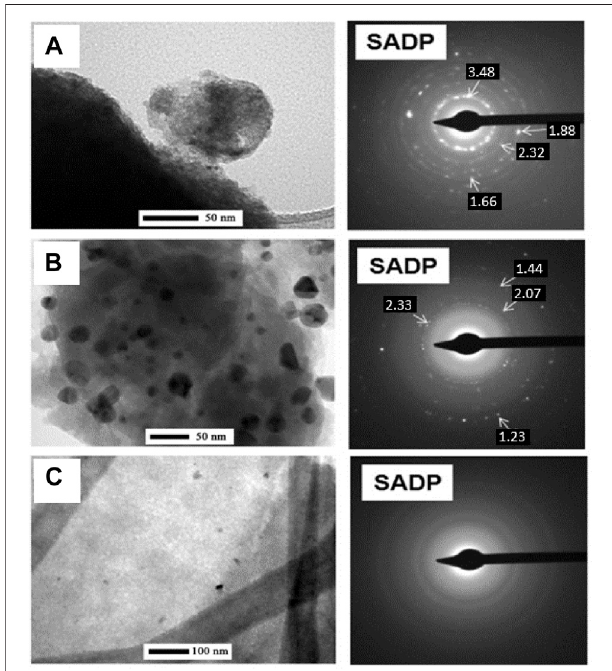
FIGURE 10 | Structural TEM analysis (including electron diffraction (SADP)) with identi fi cation of precious metals for nanocomposites such as RGO/TiO 2 (40 wt%)-Ag (1 wt%) (A) , RGO/TiO 2 (40 wt%)-Au (1 wt%) (B) , RGO/TiO 2 ( 40 wt%)-Pd (1 wt%) (C) produced using the simpli fi ed sol- gel method (Reproduced with permission from (Jastrzebska et al., 2017d) with minor